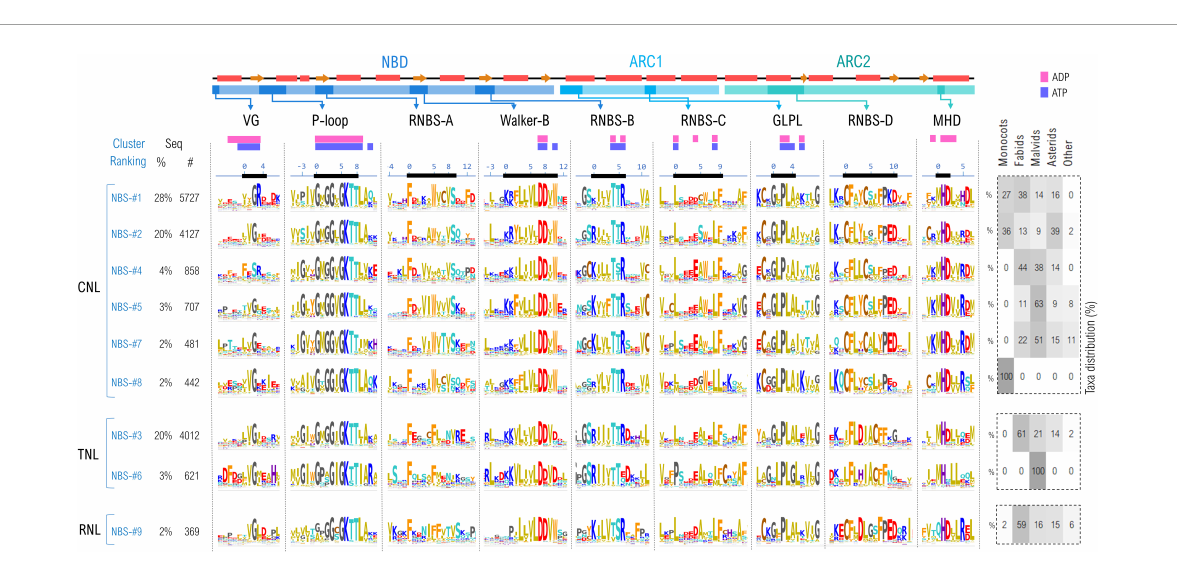
FIGURE4 Sequence clustering of NBS domains based on the confined 9 NBS motifs. Motif variability is expressed as relative entropy displayed as letter height—the larger the more conserved. Top clusters are grouped according to the preponderant NLR class: CNL, TNL, or RNL. The taxonomic distributions of each cluster is depicted in the right panel. The ADP/ATP contacts within 5Å are mapped above the motif consensus (magenta—the inactive ADP-bound ZAR1 PDB: 6j5w; purple—the activated ATP-binding ZAR1 PDB: 6j5t). Amino acids are colored as described in Figure 3